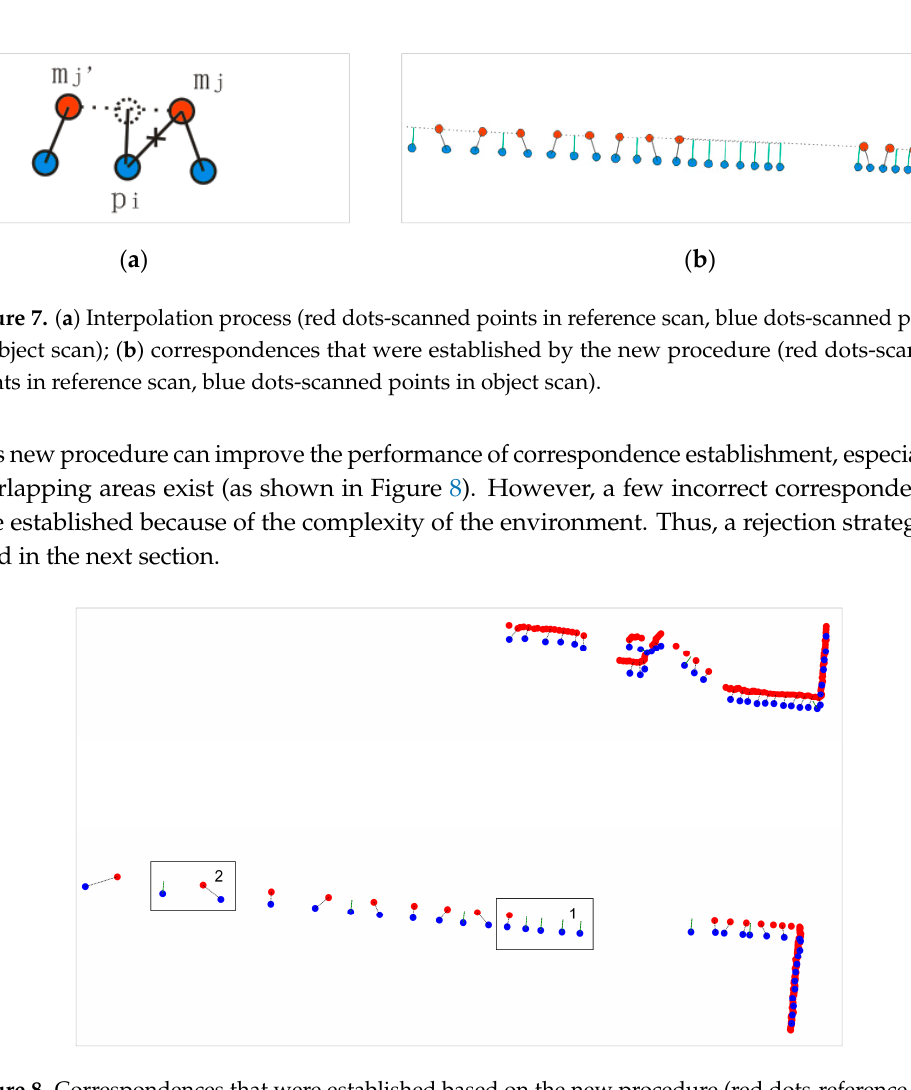
Figure 8. Correspondences that were established based on the new procedure (red dots-reference scan, blue dots-object scan).